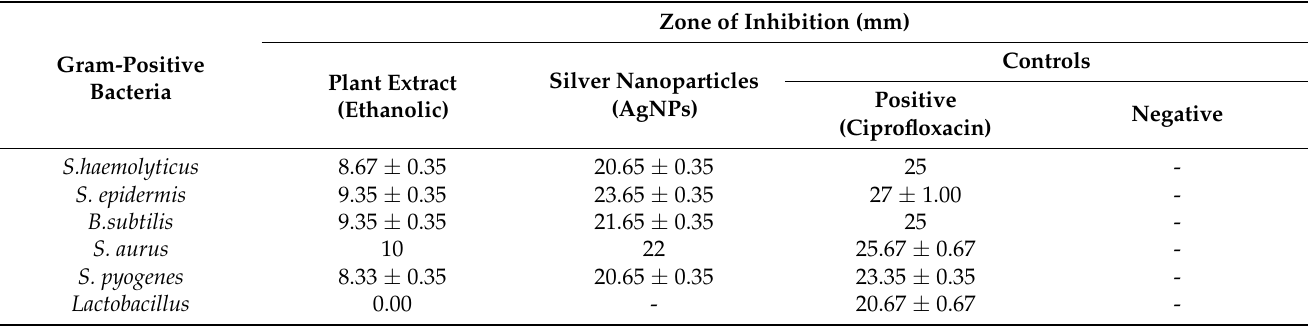
Table 1. Antimicrobial activity of ethanolic extract of S. mombin and AgNP produced with ethanolic extract of S. mombin counter to Gram-positive bacteria. The information is presented in the table with the mean ( ± SE, standard error), p < 0.05.